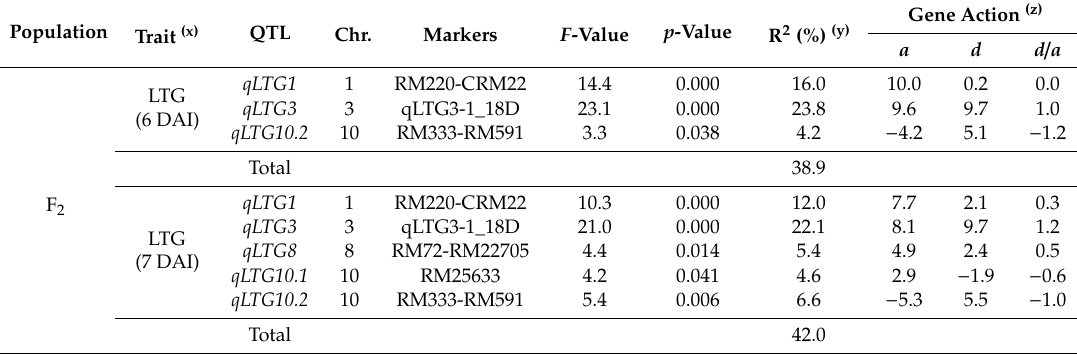
Figure 2. Frequency distribution of germination rate in 154 F 2 plants at 6 and 7 days after incubation (DAI) at 13 °C. Germination rate was measured at 4–8 (DAI). Arrows indicate mean germination rate of CR1517 and CR1518 lines. Table 2. List of QTLs identified for low-temperature germinability in F 2 population.